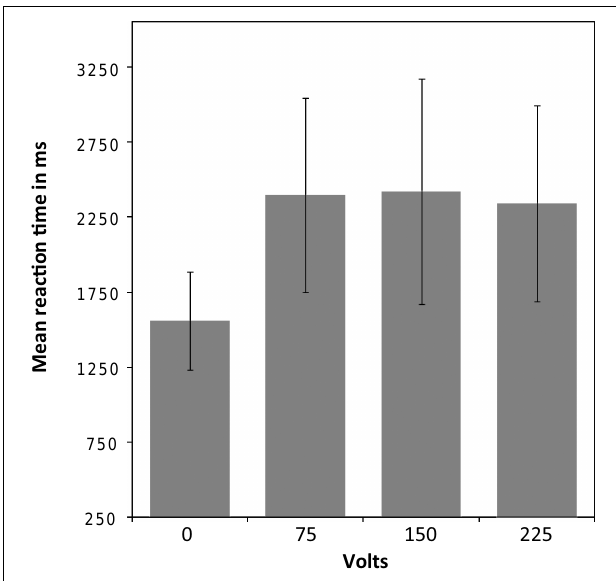
FIGURE 2 | Mean reaction time for pain and non-pain button responses. A mixed-effects ANOVA (Greenhouse-Geisser adjusted) revealed a signifi cant interaction between condition [volt level: 0 (i.e., non-pain condition), 75, 150, and 225] and reaction time (RT) [ F (1.36,20.42) = 24.9, p = < 0.001]. Within- subject contrasts showed a signifi cant difference in RT between the non-pain condition and the pain condition as a whole, with shorter RT for the non-pain condition, but no signifi cant differences between the shock levels within the pain condition.